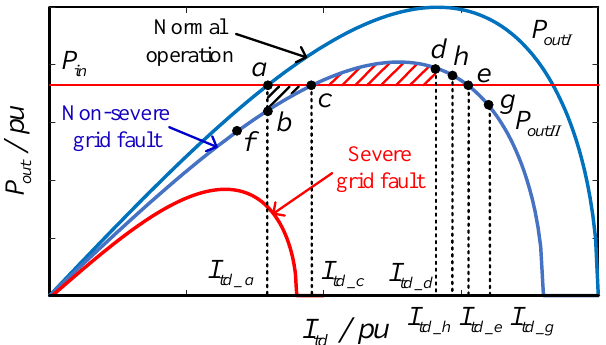
Figure 6. Different output power characteristic curves under severe and non-severe remote volt- age sag.